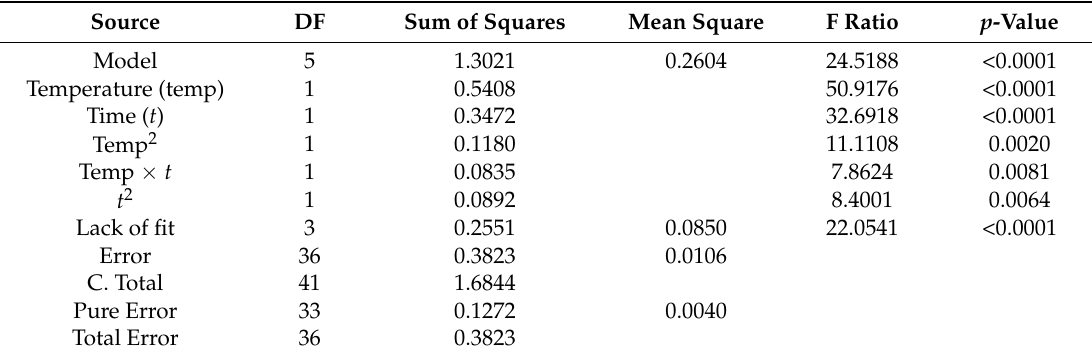
Table 9. ANOVA for effect of time ( t ) and temperature (temp) for trypsin inhibitor activity for conventional